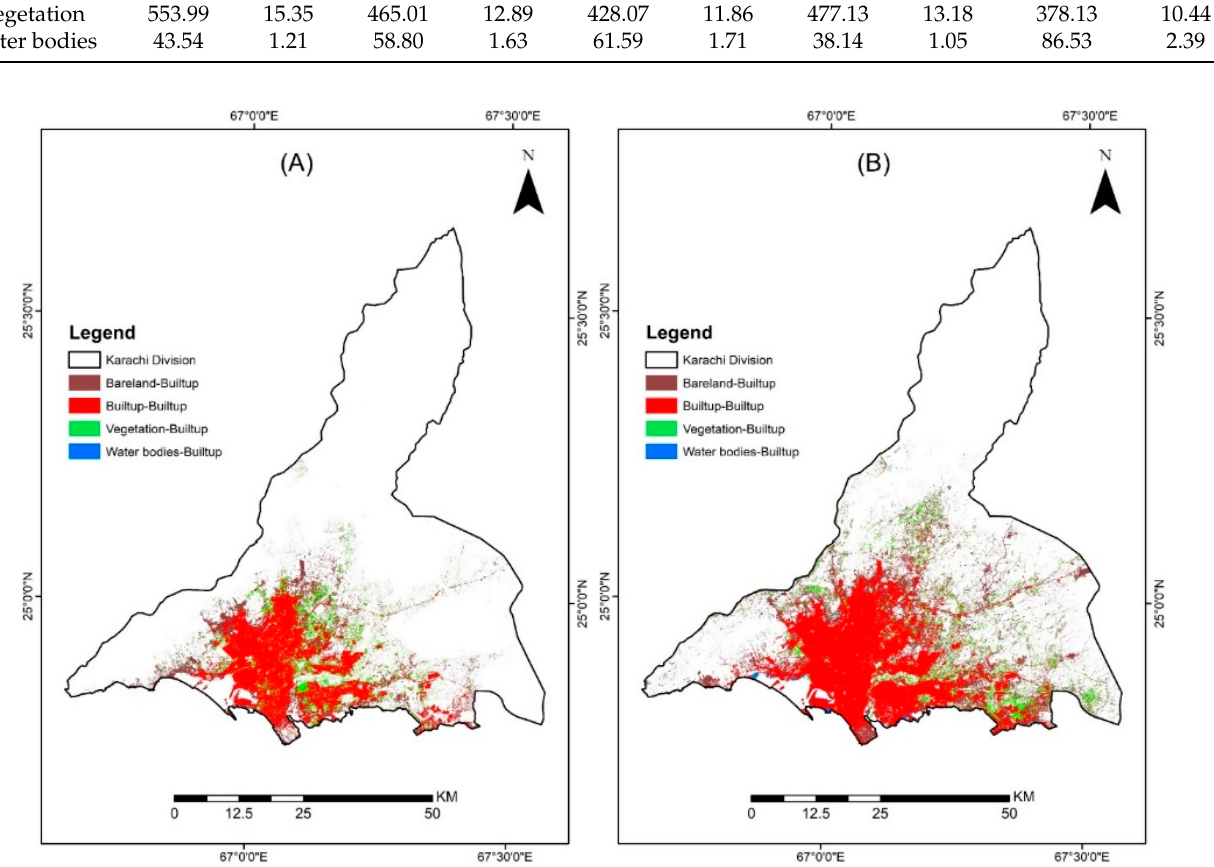
Figure 4. Details of the transition from other land use/land cover types to the built-up area class: ( A